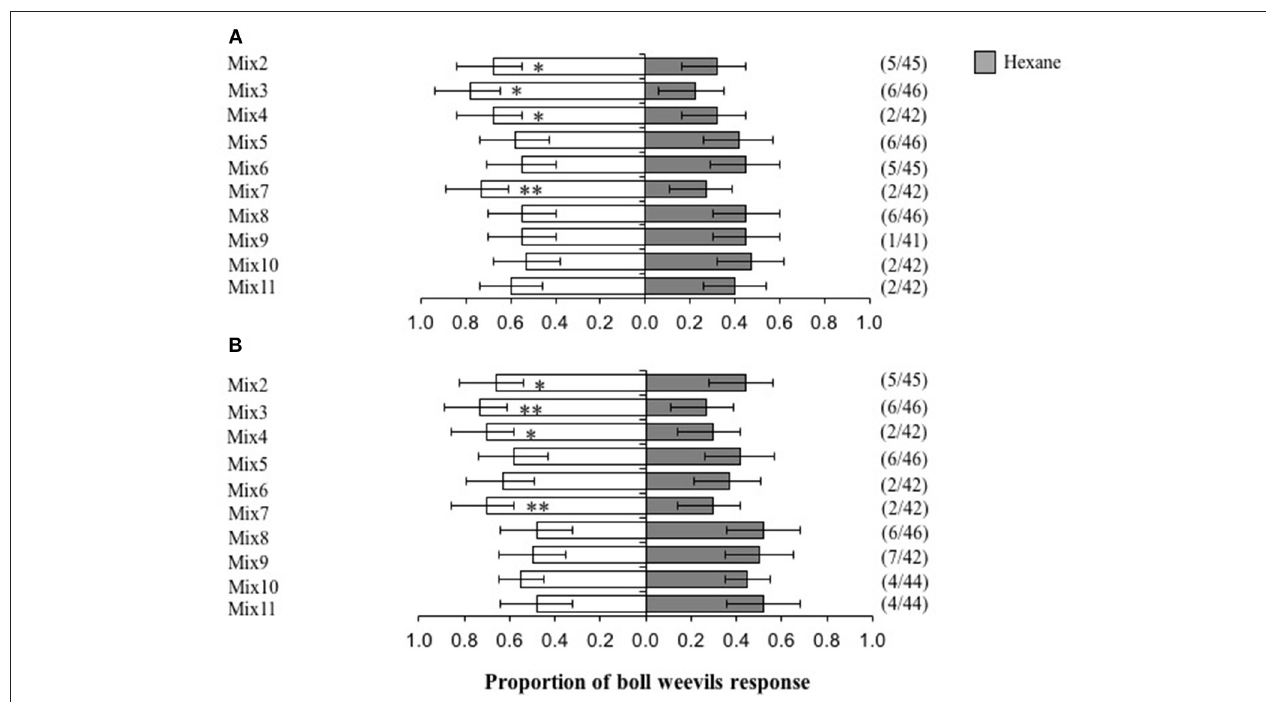
FIGURE 6 | First choice of male (A) and female (B) boll weevils, Anthonomus grandis , in a Y-tube olfactometer, to synthetic blends at the same concentration and ratio as in volatile samples collected from boll weevil-damaged cotton plants at the reproductive stage (for composition of blends, see Table 1 ). Asterisks indicate differences (*0.05 > P > 0.01, **0.01 > P > 0.001) between pairs of treatments. Bars indicate 95% of confidence interval. Numbers in parentheses indicate insects that did not respond to either tested treatments/total amount of bioassays.